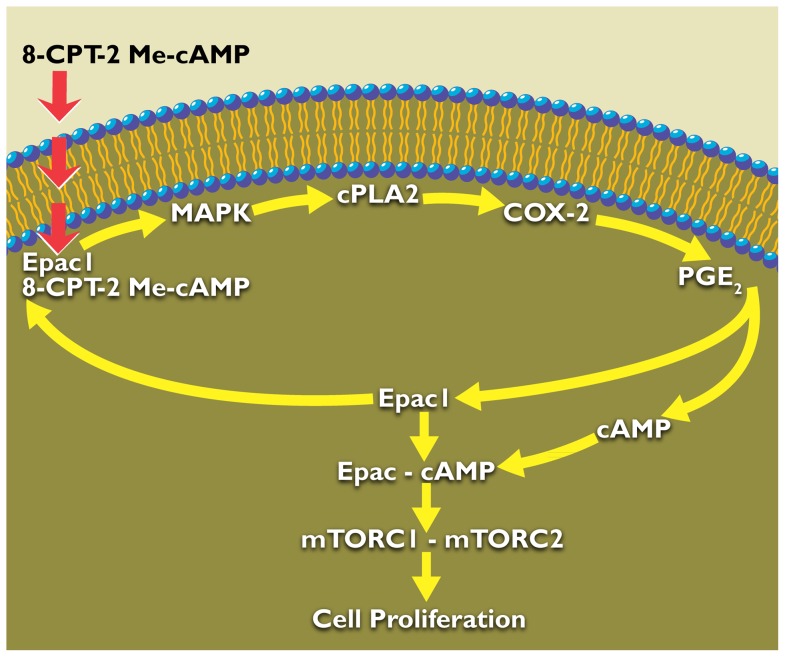
A schematic representation of a cyclic autocrine feedback loop promoting human prostate cancer cell proliferation.